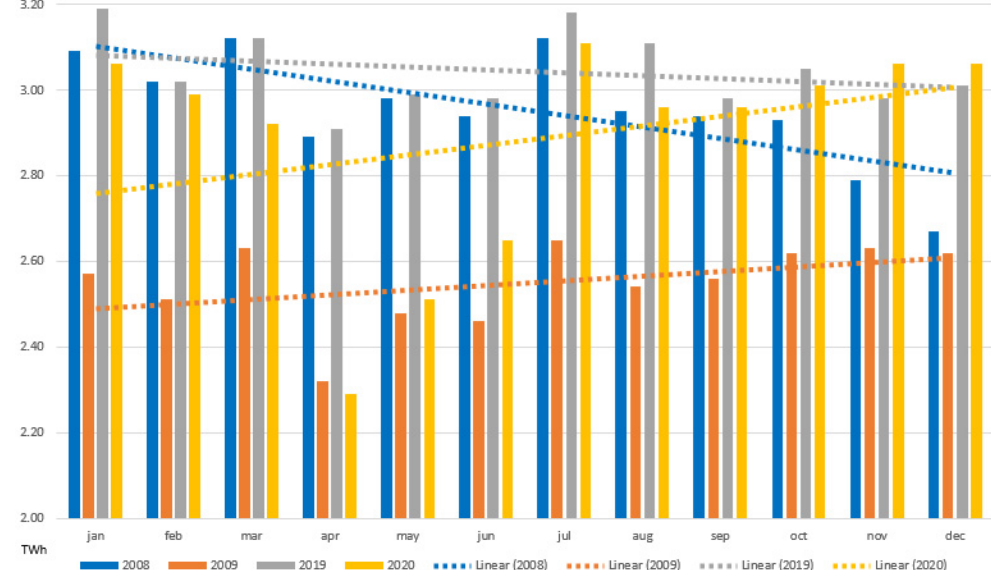
Figure 9. Comparative evolution of monthly non-household electricity consumption (NHEC) during the financial crisis vs. the COVID-19 crisis.